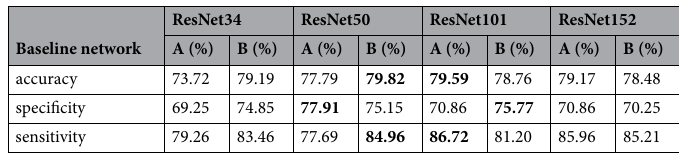
Table 2. Comparison of baseline classification networks. Significant values are in bold.